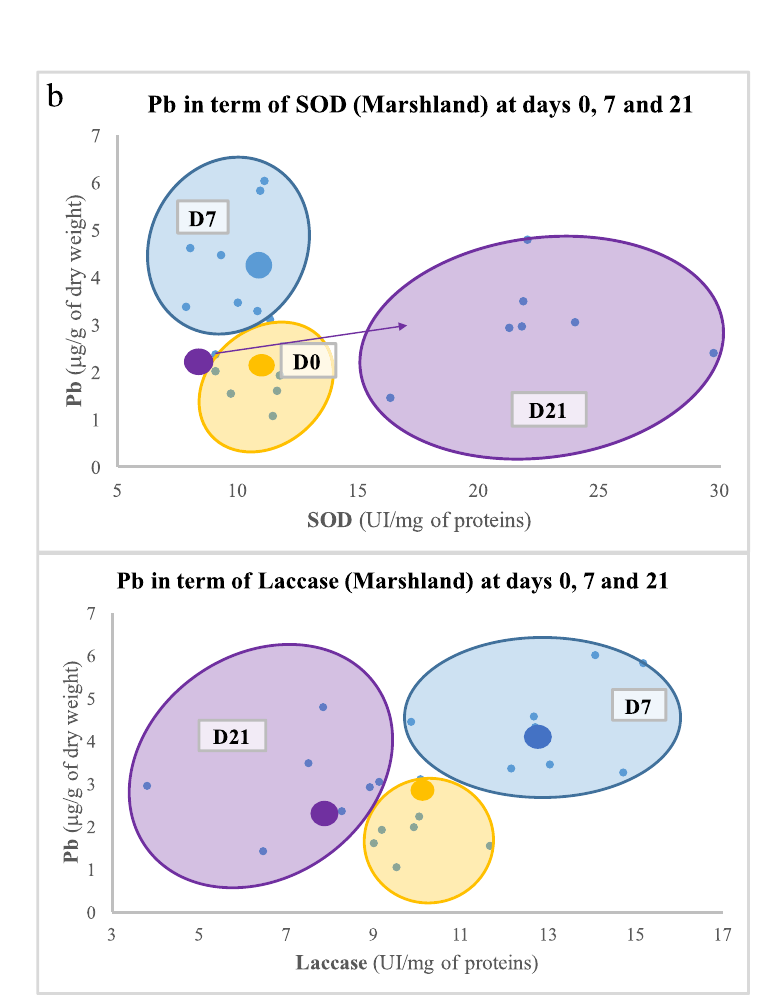
Fig 6. a Graph interpretation illustration for all graphics below, and b Specific pollution of Pb depending on SOD (struggle against ROS) and Laccase (immunomodulation) at the Houmeau marshland site.